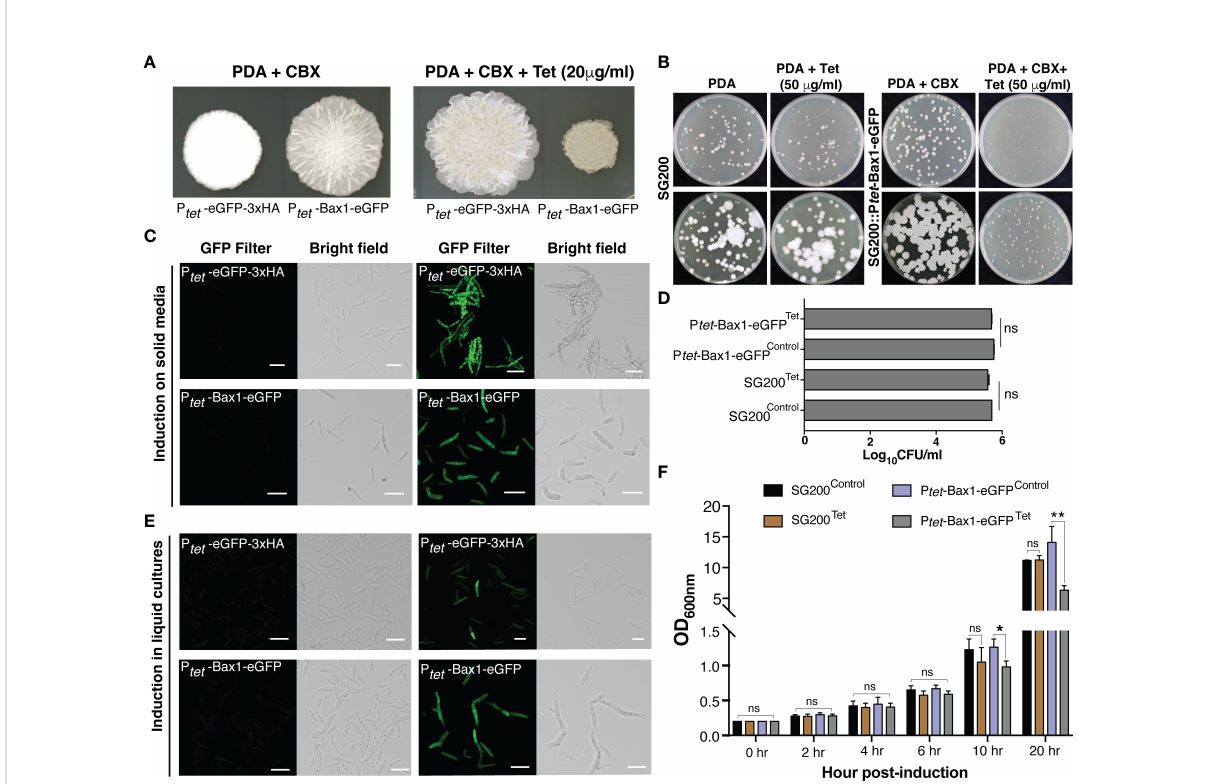
FIGURE 3 Tetracycline regulated expression of toxic gene Bax1 in U. maydis . (A) Growth of indicated U. maydis strains on PDA+CBX ± Tet (20 m g/ml) plates after day 4 of spotting. (B) The phenotype of SG200 and SG200::P tet -Bax1-eGFP colonies on PDA ± Tet (50 m g/ml) induction at 3 rd and 5 th day. (C) Confocal images of cells from SG200:P tet -eGFP-3xHA and SG200:P tet -Bax1-HA-eGFP after 4 days of growth on PDA+CBX ± Tet (20 m g/ml) plates. (D) Graph showing CFU/ml counted from (B) . (E) Confocal images of cells from one day grown liquid uninduced and induced cultures of SG200:P tet -eGFP-3xHAand SG200:P tet -Bax1-HA-eGFP (Scale bar in all images = 20 m m). (F) Growth curve (OD 600 graph) of U. maydis cultures of indicated strains ± Tet (100 m g/ml), X-axis indicates time points as hpi, and Y-axis indicates OD 600. Signi fi cant differences were determined using Student ’ s t-test (* p < 0.05, **P < 0.01; ns, not signi fi